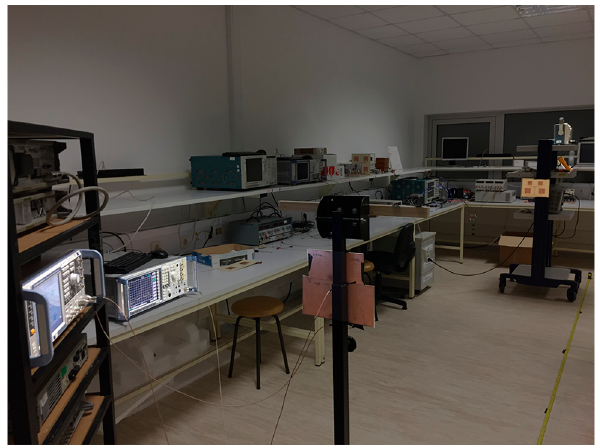
Figure 7. Measurements setup.